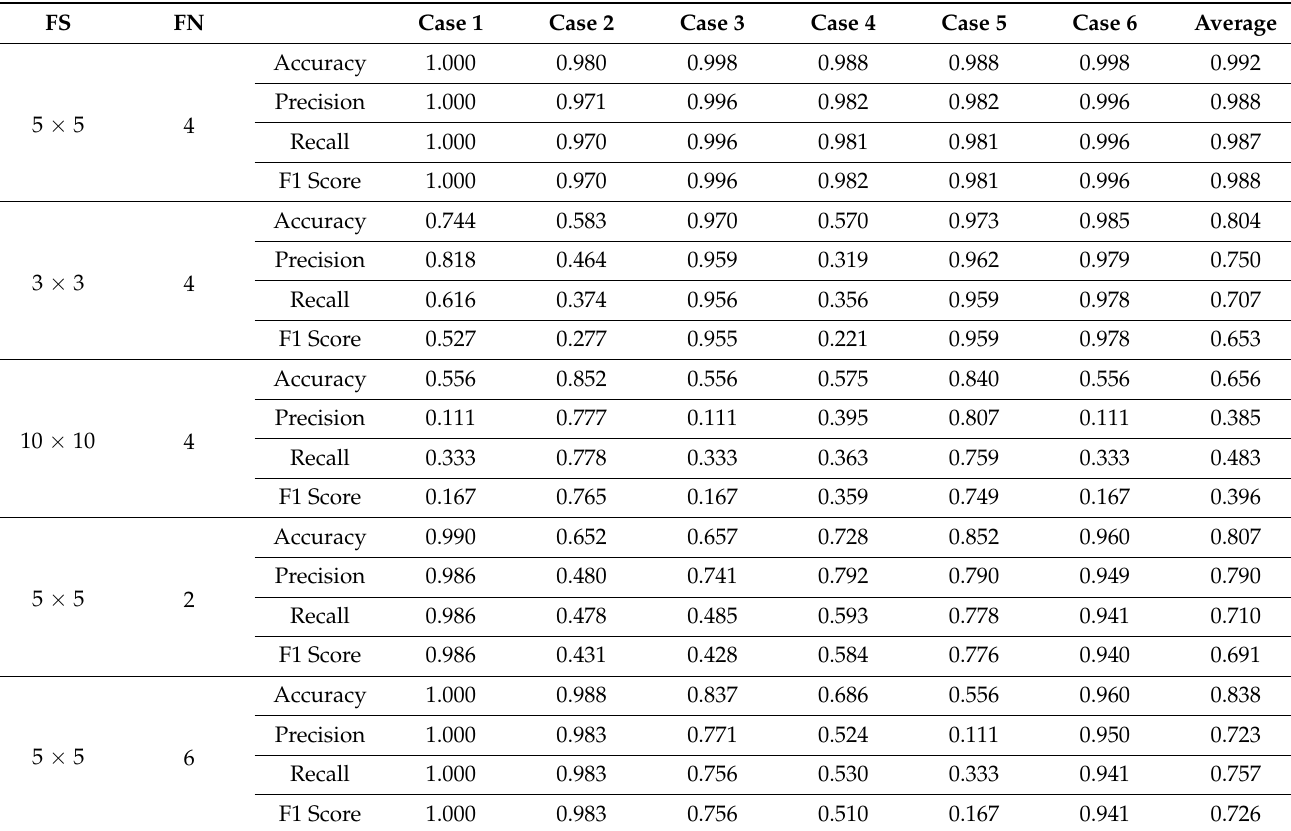
Table 3. Performance parameters for evaluation of CNN architecture for all cases of different number and sizes of filters including both